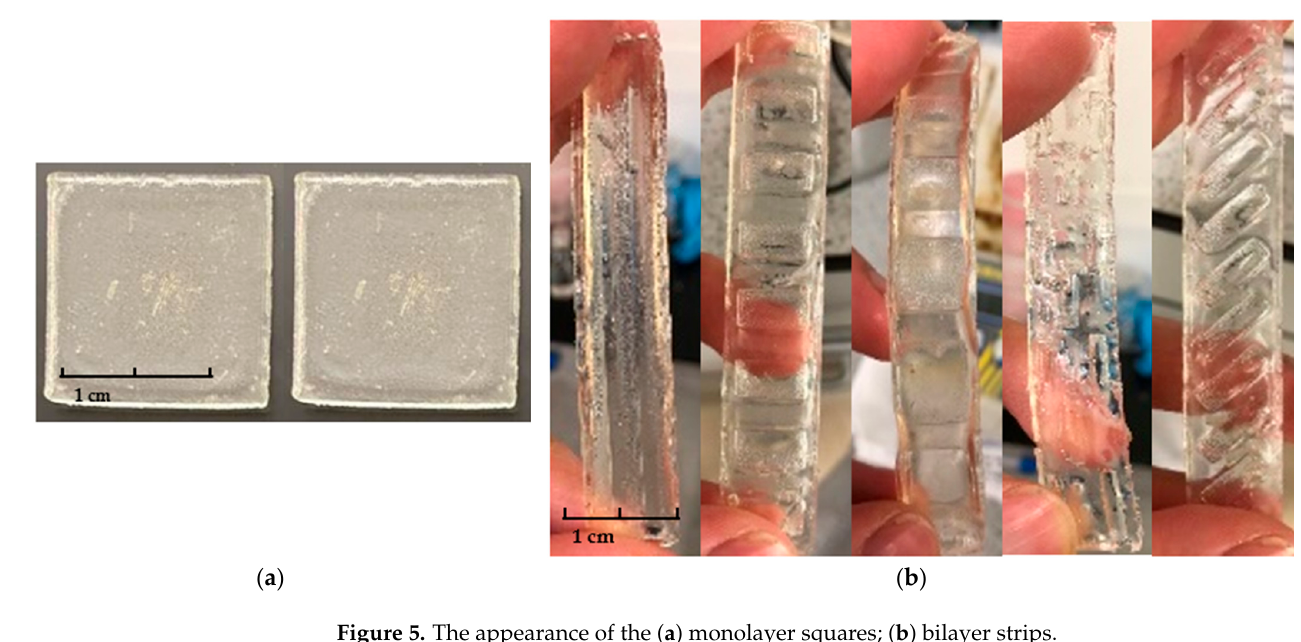
Figure 5. The appearance of the ( a ) monolayer squares; ( b ) bilayer strips.